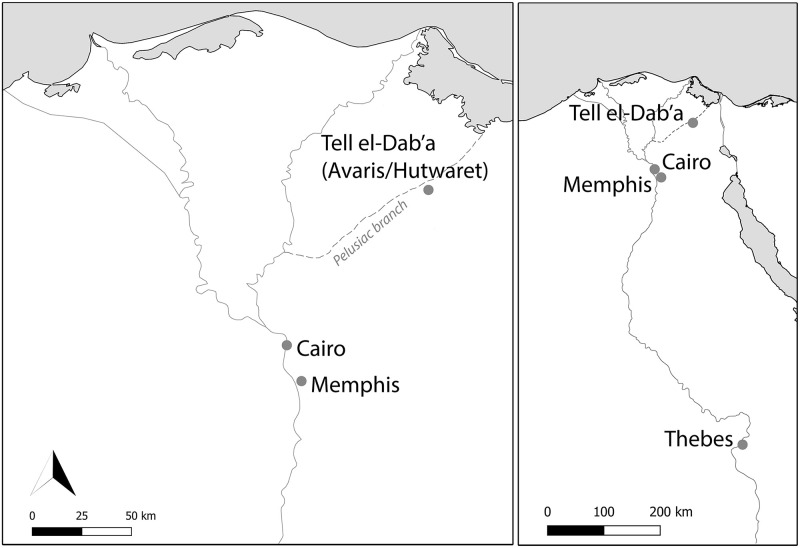
Location of Tell el-Dabca in Egypt’s eastern Delta.